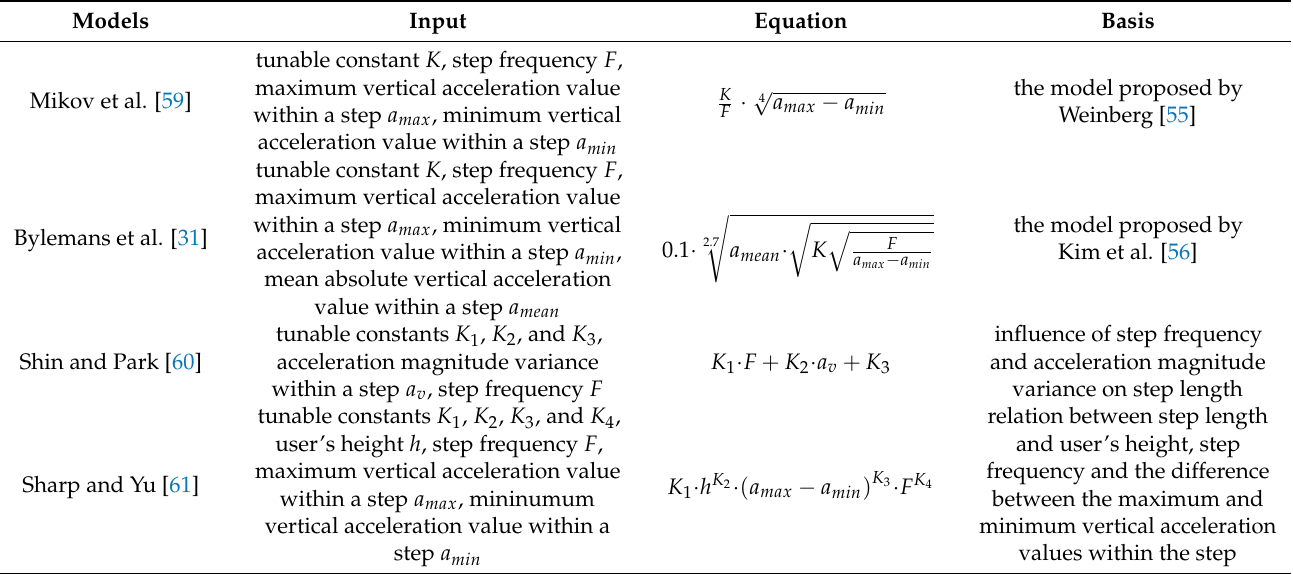
Table 2. Characteristics of models selected for the